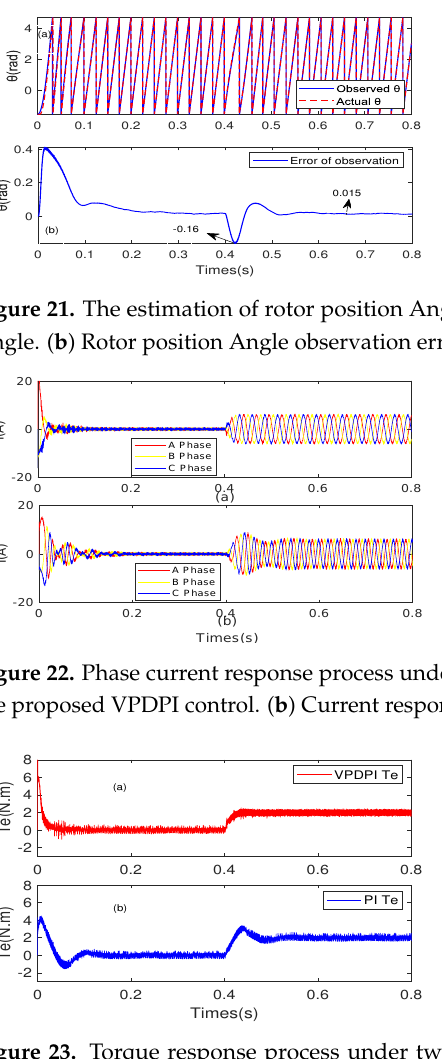
Figure 23. Torque response process under two control methods. ( a ) Torque response under the proposed VPDPI control. ( b ) Torque response under the PI control